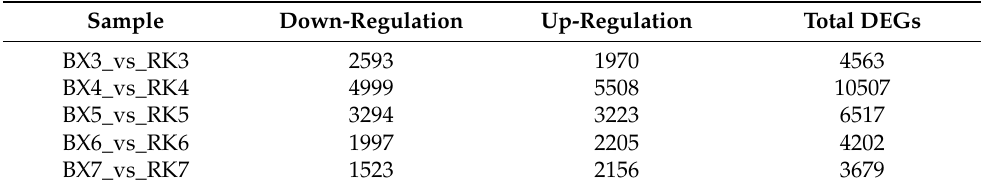
Figure 2. DEG analysis between ‘BX’ and ‘RK’ at different growth stages. ( A ) DEGs (FDR, p ≤ 0.01, FC ≥ 2) from the third week to the sixth week. Red and green points represent the up-regulated and down-regulated genes in ‘BX’, respectively; ( B ) numbers of up-regulated genes between the third week and fourth week in ‘BX’; ( C ) numbers of up-regulated genes between the third week and fourth week in ‘RK’. Table 1. DEGs at different growth stages of ‘BX’ and